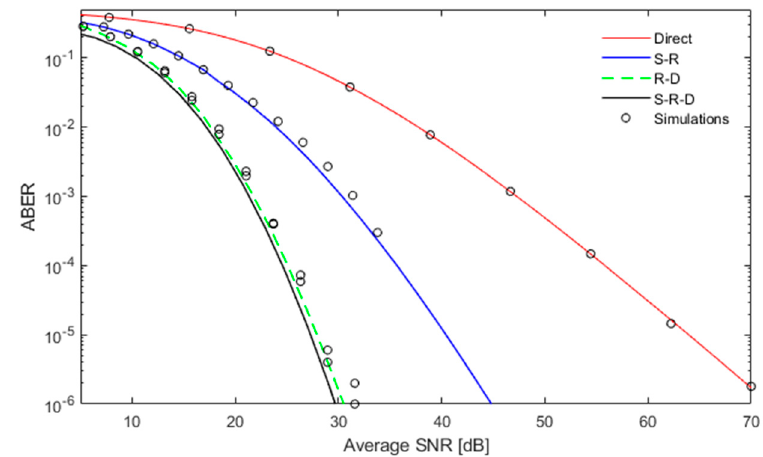
Figure 11. ABER vs. SNR of FSO over G-G channel for strong turbulence with distance 500–500 m, the number of relays =3, and w z = 2 m.